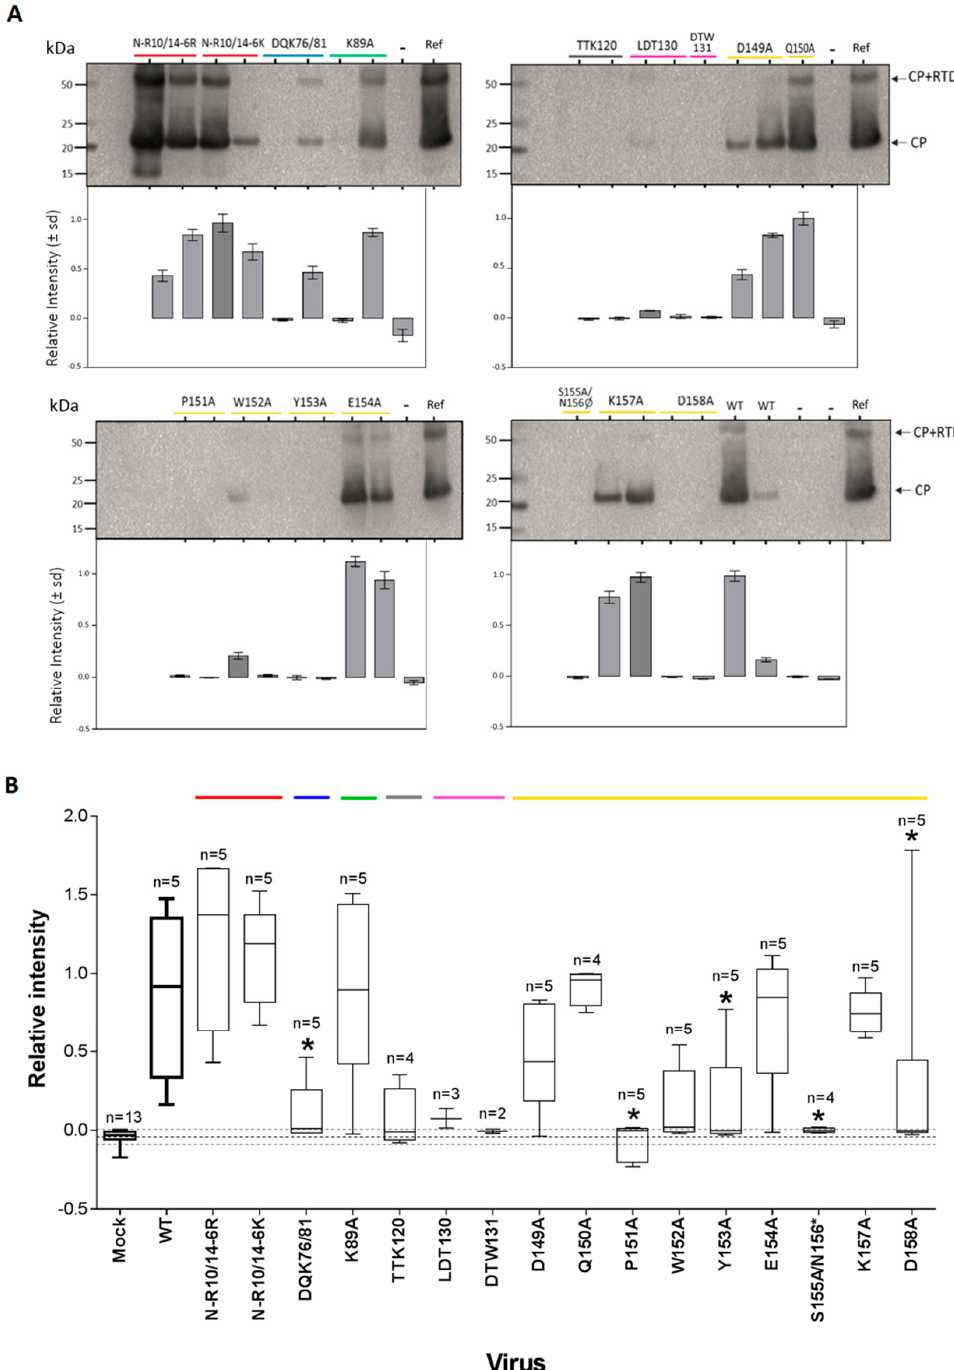
Figure 5. Detection of virion structural proteins in pea plants infected with WT or CP mutants by Western blot. ( A ) Western blot images (upper) were scanned and processed using GelQuant to estimate the relative amount of CP (histogram below) to an external positive control (named Ref); ( B ) relative intensity of CP bands pooling biological replicates from two independent experiments. The quantity of CP in the upper leaf for each virus is shown, with significant differences relative to WT indicated (* p < 0.05). Mutations in the S domain (grey domain) resulted in a weak expression of structural proteins of certain mutants previously positive by RT ‐ qPCR. Only the mutant Q150A was efficiently transmitted by aphids. Leaves from plants infected with WT PEMV and uninfected leaves were used as positive and negative controls, respectively. Colored lines indicate the region in the CP for each mutation, as indicated in Figure 1A.